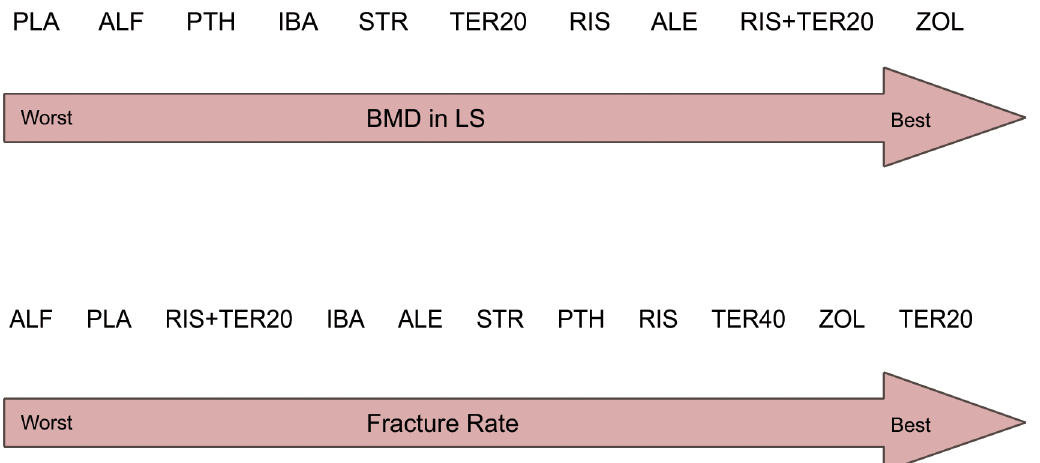
Fig 5. Ranking of treatments in terms of the BMD in LS and fracture rate. ALE: Alendronate; PLA: Placebo; ALF: Alfacalcidol; RIS: Risedronate; IBA: Ibandronate; ZOL: Zoledronate; STR: Strontium Ranelate; TER: Teriparatide; PTH: Parathyroid Hormone.